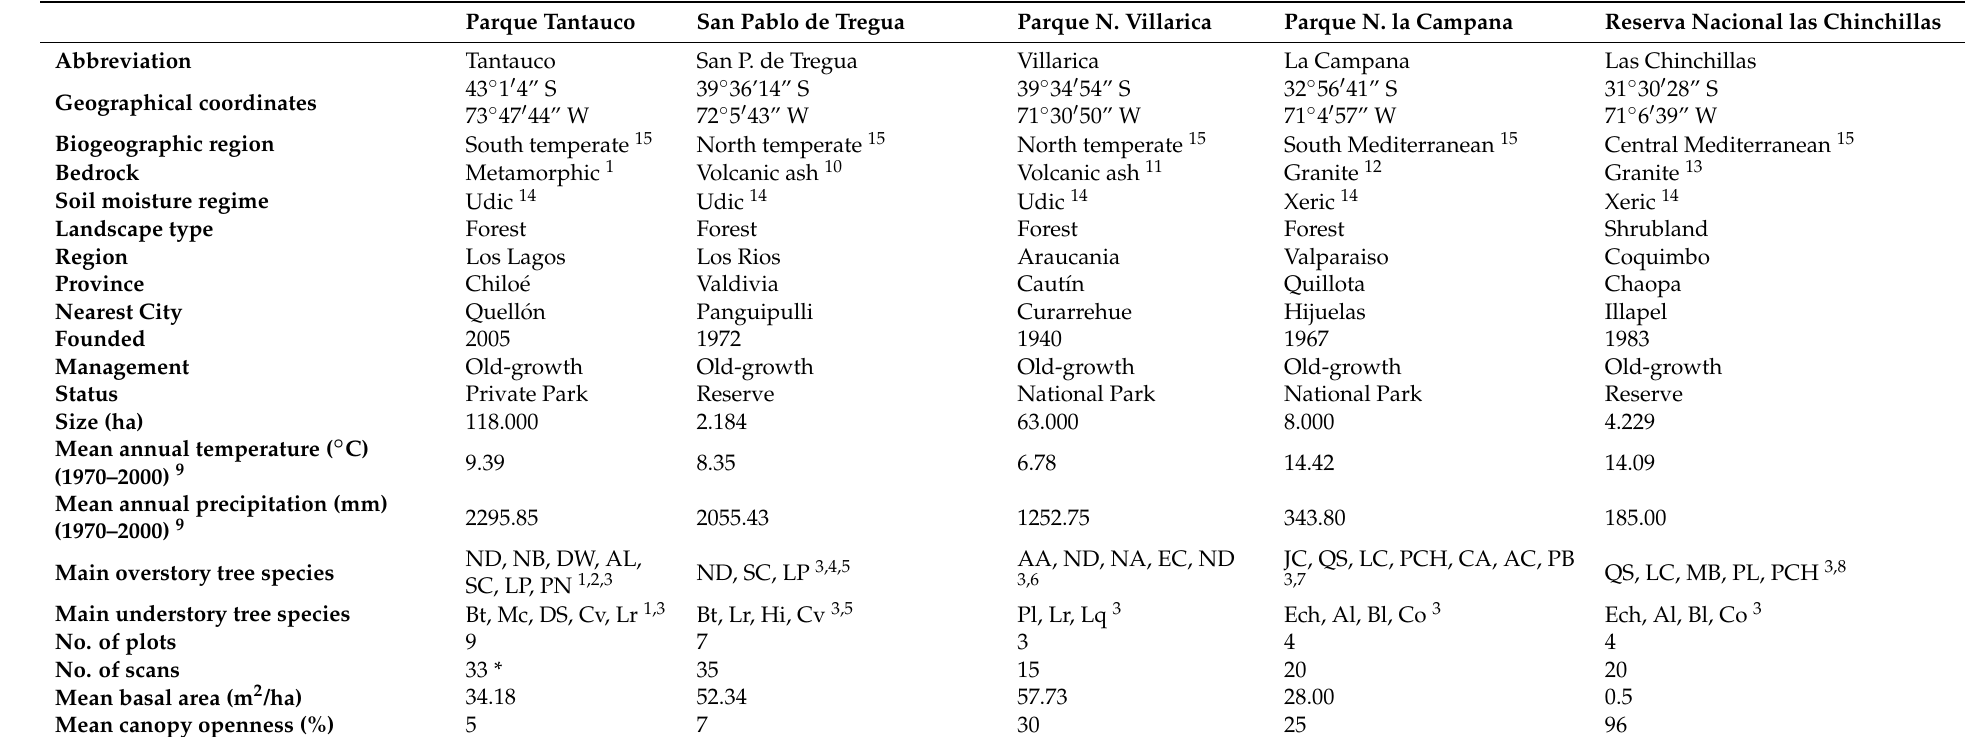
Table 1. Main characteristics of the five investigated